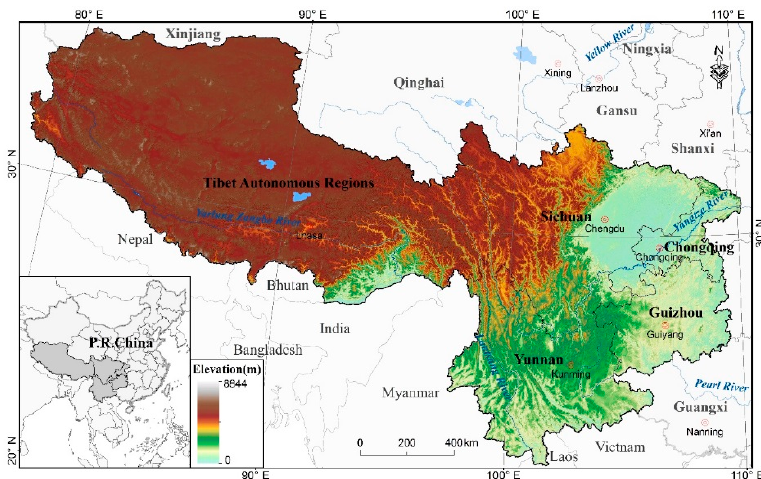
Figure 1. The location of Southwestern China.